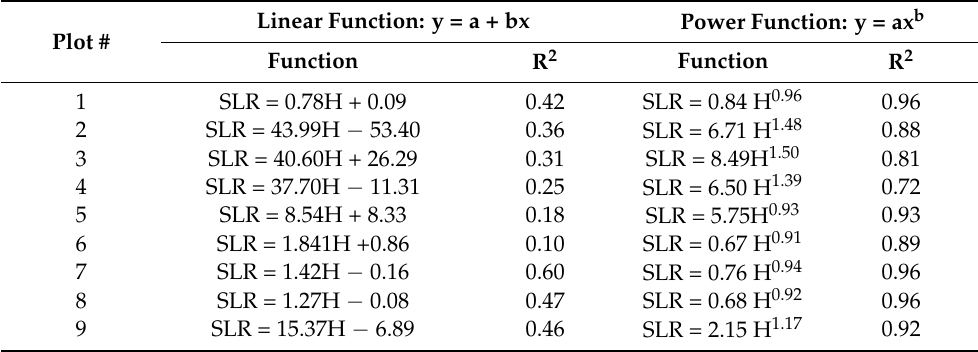
Table 7. Relationships between runoff depth (H) and soil loss rate (SLR) from the plots for the 66 erosive rainfall events.